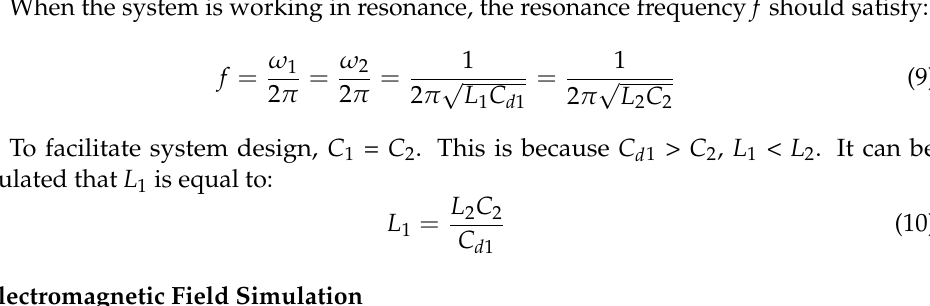
the resonant capacitor. Figure 8. DWPT system simulation model.